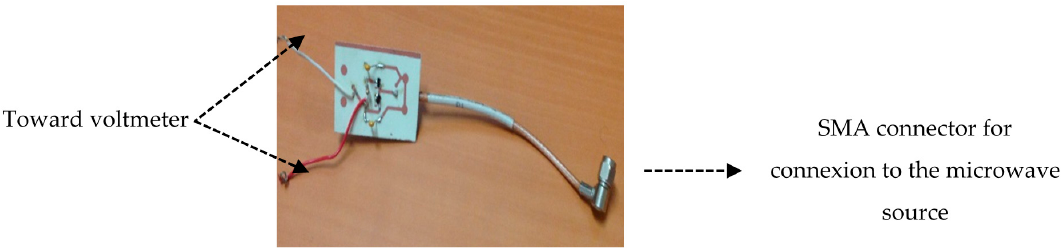
Figure 15. Fabricated Printed Circuit Board (PCB) of the Rectifier.